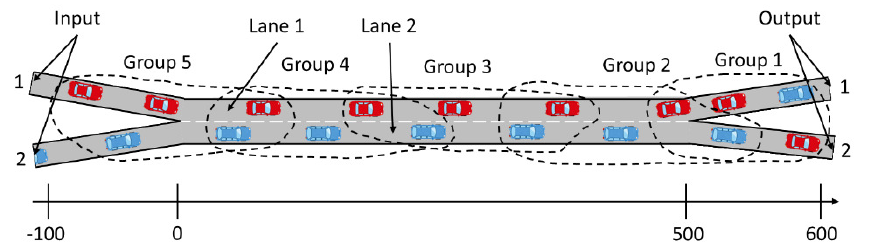
Figure 4. Multi-lane road network used for simulation and evaluation of the proposed traffic coordination